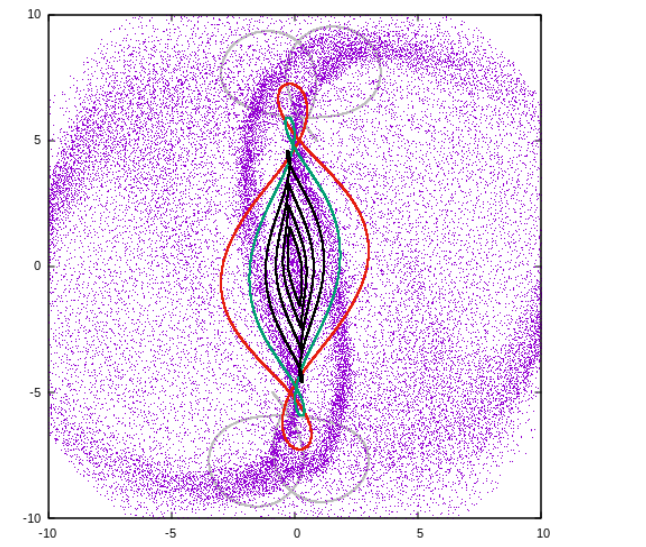
Figure 11. Stable x1 orbits (black, green and red) and the (grey) loops of an 6:1 f orbit (see Figure 4). The straight-line shocks are formed in the region occupied by the black x1 POs. The shocks avoid the loops, while the unstable f orbit does not affect the